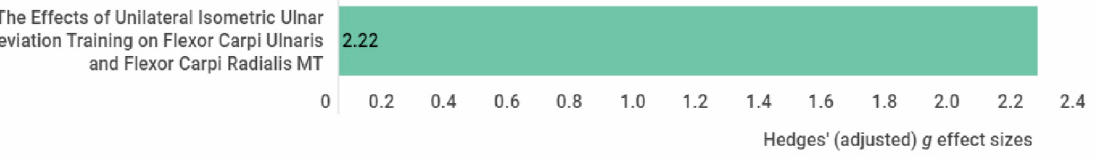
Figure 28. The effect size of the exercise interventions on the forearm flexors muscle thickness. The green colour indicates a large effect size. Abbreviations: MT, muscle thickness.